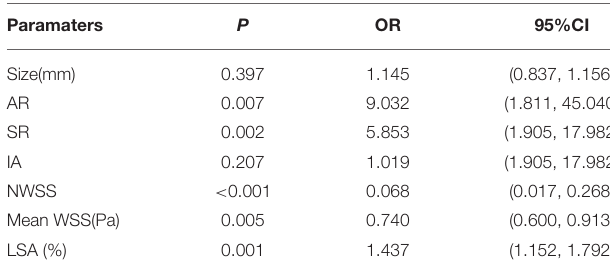
TABLE 4 | The result of multiple logistic regression analysis.